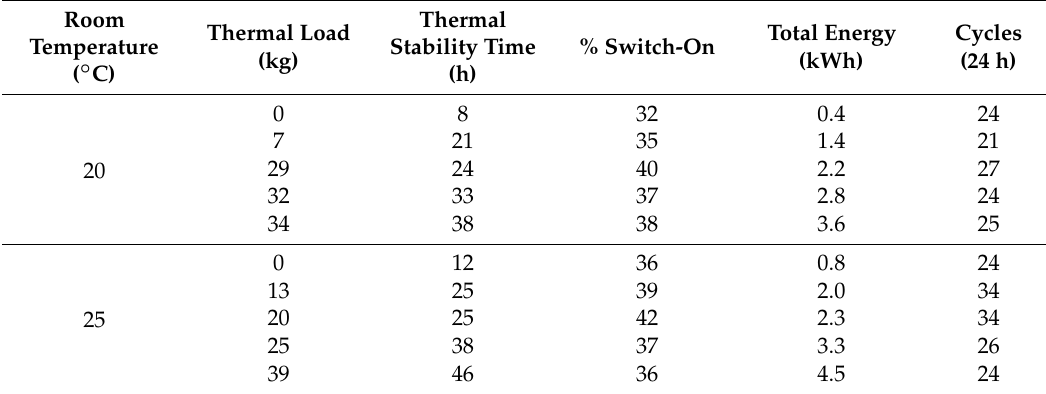
Table 3. Energy behavior at different loads and constant ambient temperature. 257